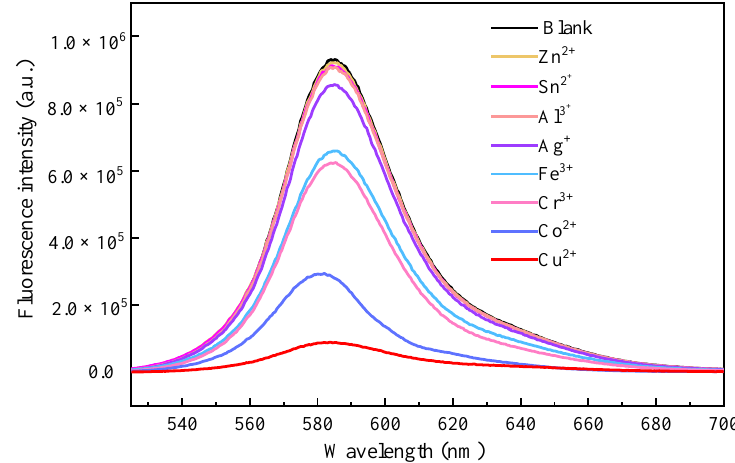
Figure 4. Fluorescence spectra of P(MMA-co-RB) (0.5 mg/mL in DMF, λ ex = 510 nm) with different cations (5 mM).